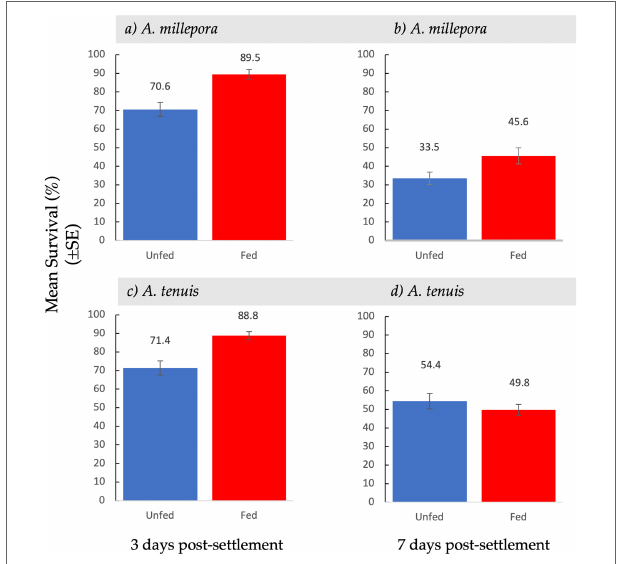
FIGURE 4 | Mean survival ( ± SE) of Acropora millepora (A, B) and Acropora tenuis spat (C, D) from unfed and fed treatments, three days (A, C) and seven days (B, D) after larvae were provided with settlement